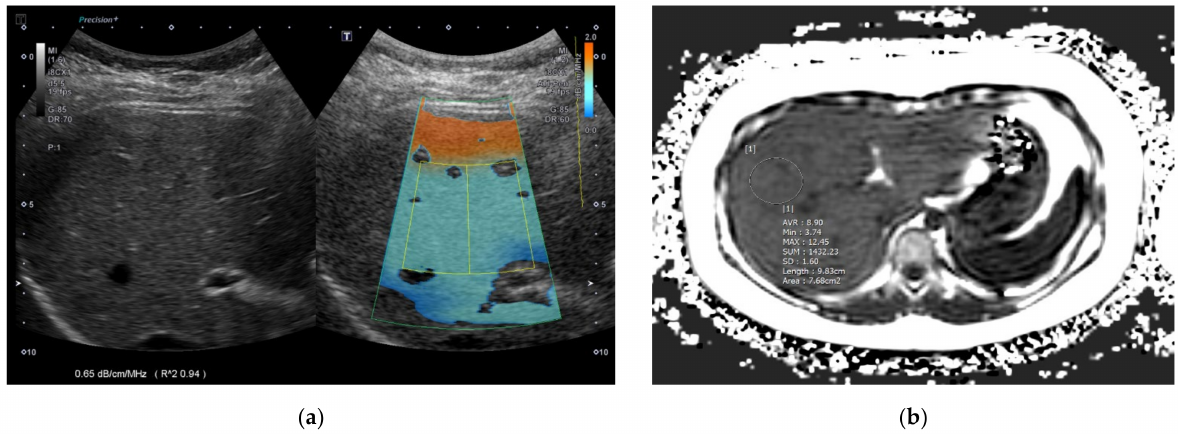
Figure 1. A 7-year-old girl in the mild fatty liver group according to grayscale US. ( a ) The ATI value was 0.65 dB/cm/MHz and ( b ) MRI-PDFF value was 8.9% (S1: PDFF > 6%). US: ultrasonography; ATI: attenuation imaging; MRI: magnetic resonance imaging; PDFF: proton density fat